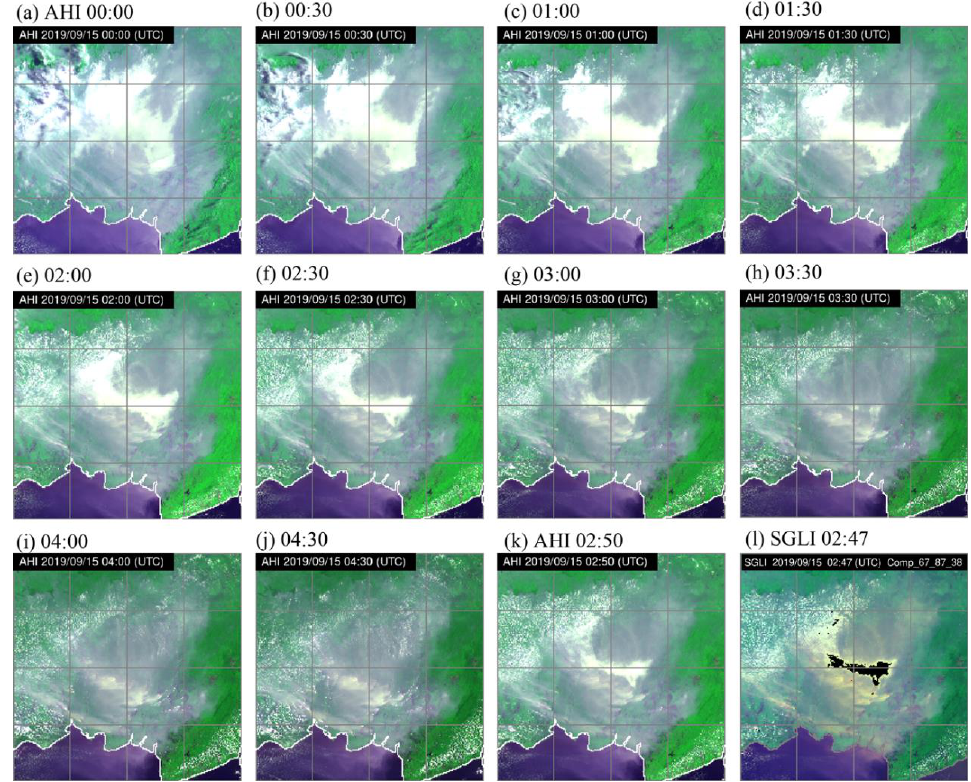
Figure 12. Sequential images at 30-minutes intervals from (a) 00:00 to (j) 04:30 observed by Himawari-8/AHI on 15 September 2019. Note that figure ( l ) presents the image observed by GCOM-C/SGLI at approximately the same time as that by Himwari-8/AHI in figure (k).